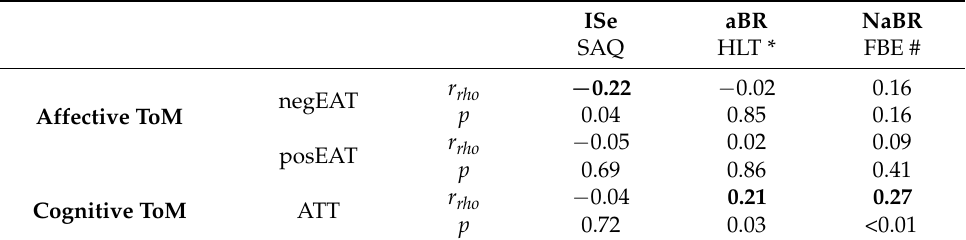
Table 2. Spearman correlation coefficients between the cognitive and affective components of ToM measures on the one hand and the ISe, aBR, and NaBR measures on the other.